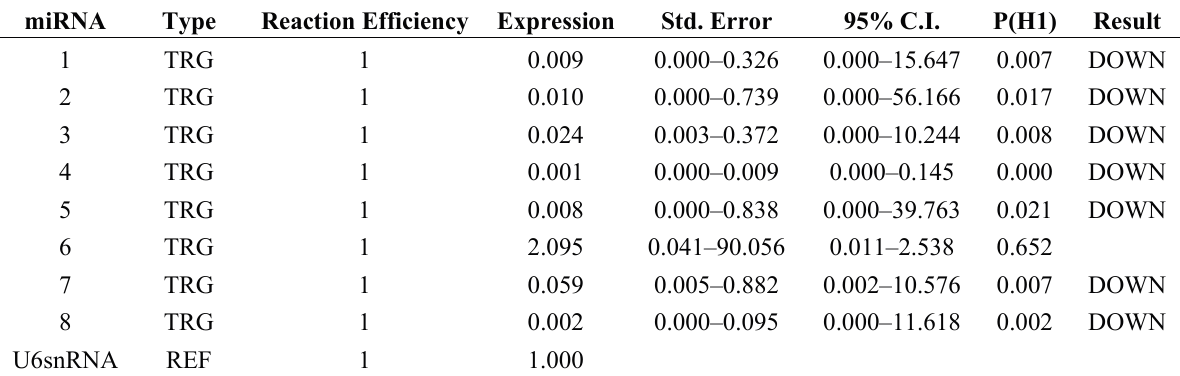
Figure 3. Relative expression (concentration) of the miRNAs analyzed in this study in samples collected in 2009 and frozen at − 80 °C compared with fresh samples. 1 = miR-125b-5p; 2 = miR-425-5p; 3 = miR-200b-5p; 4 = miR-200c-3p; 5 = miR-579-3p; 6 = miR-212-3p; 7 = miR-126-3p; 8 = miR-21-5p. Table 4. Relative expression (concentration), standard error, 95% confidence interval (C.I.), and p -value of miRNAs analyzed in this study (samples collected in 1999 and stored at − 80 °C compared with fresh samples). All miRNAs decreased significantly, except miRNA-212-3p ( # 6) that shows no significant